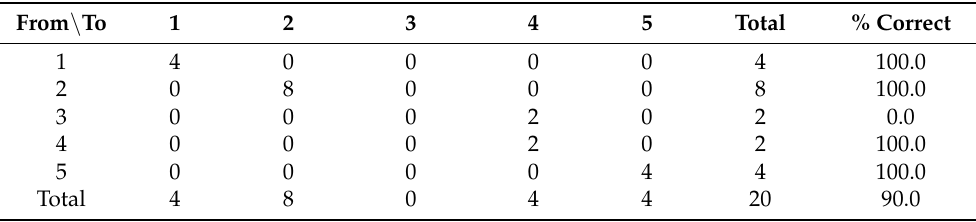
Table 2. Classification tree analysis. Predicted confusion matrix of spoiled and normal Spanish-style Manzanilla table olive fermentation samples. The codes are as follows: 1, butyric fermentations